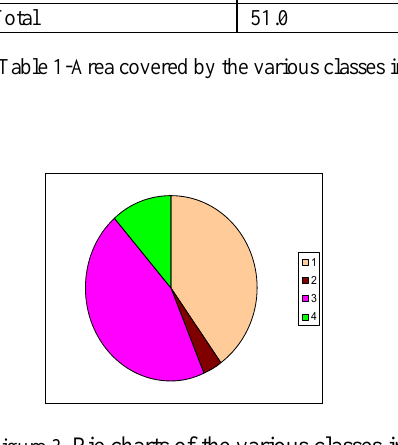
Figure 3. Pie charts of the various classes in